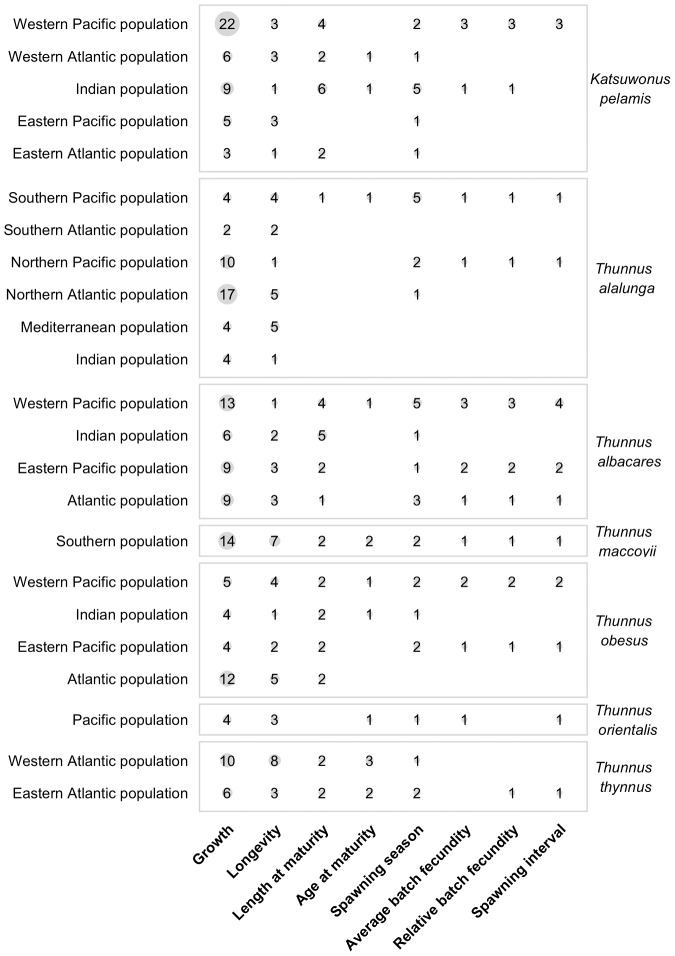
Synthesis of life history information in principal market tuna species.Number of estimates for each life history trait in the 23 populations of seven principal market tuna species. The area of the grey circles is proportional to the number of estimates available for each trait.